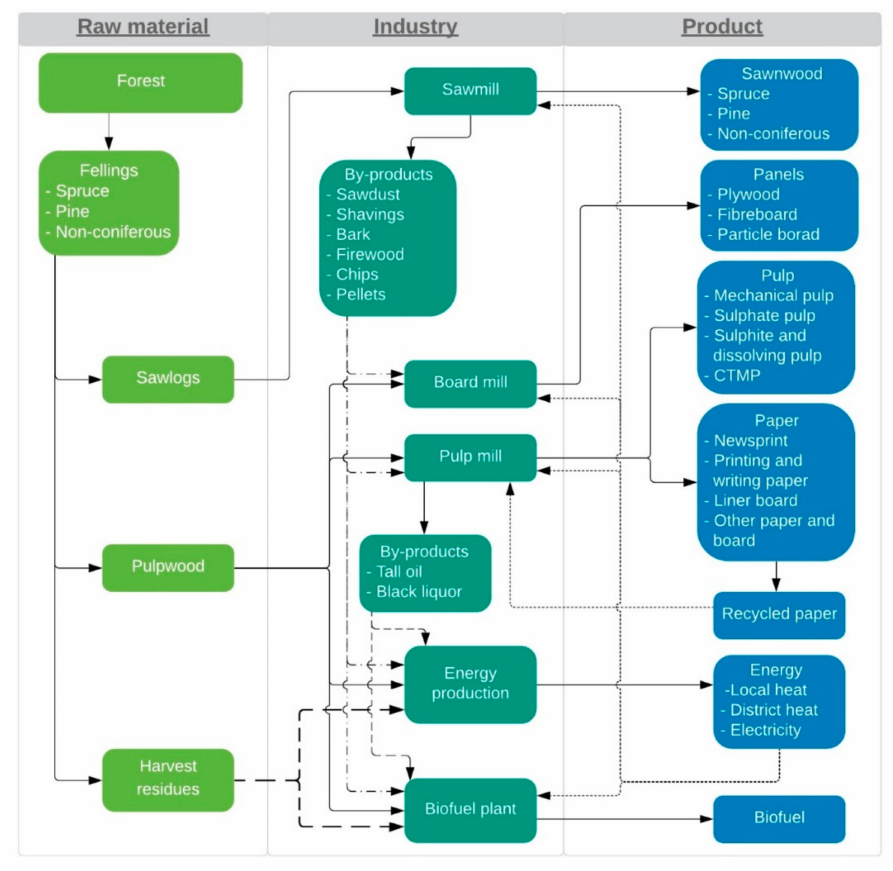
Figure 5. Schematic representation of the forest sector